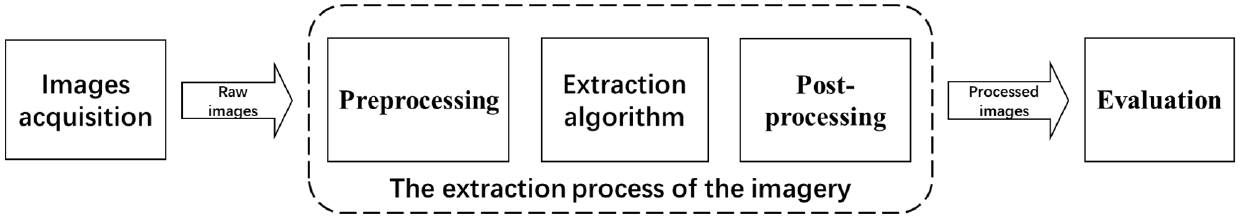
Figure 2. The flow of image boundary extraction.